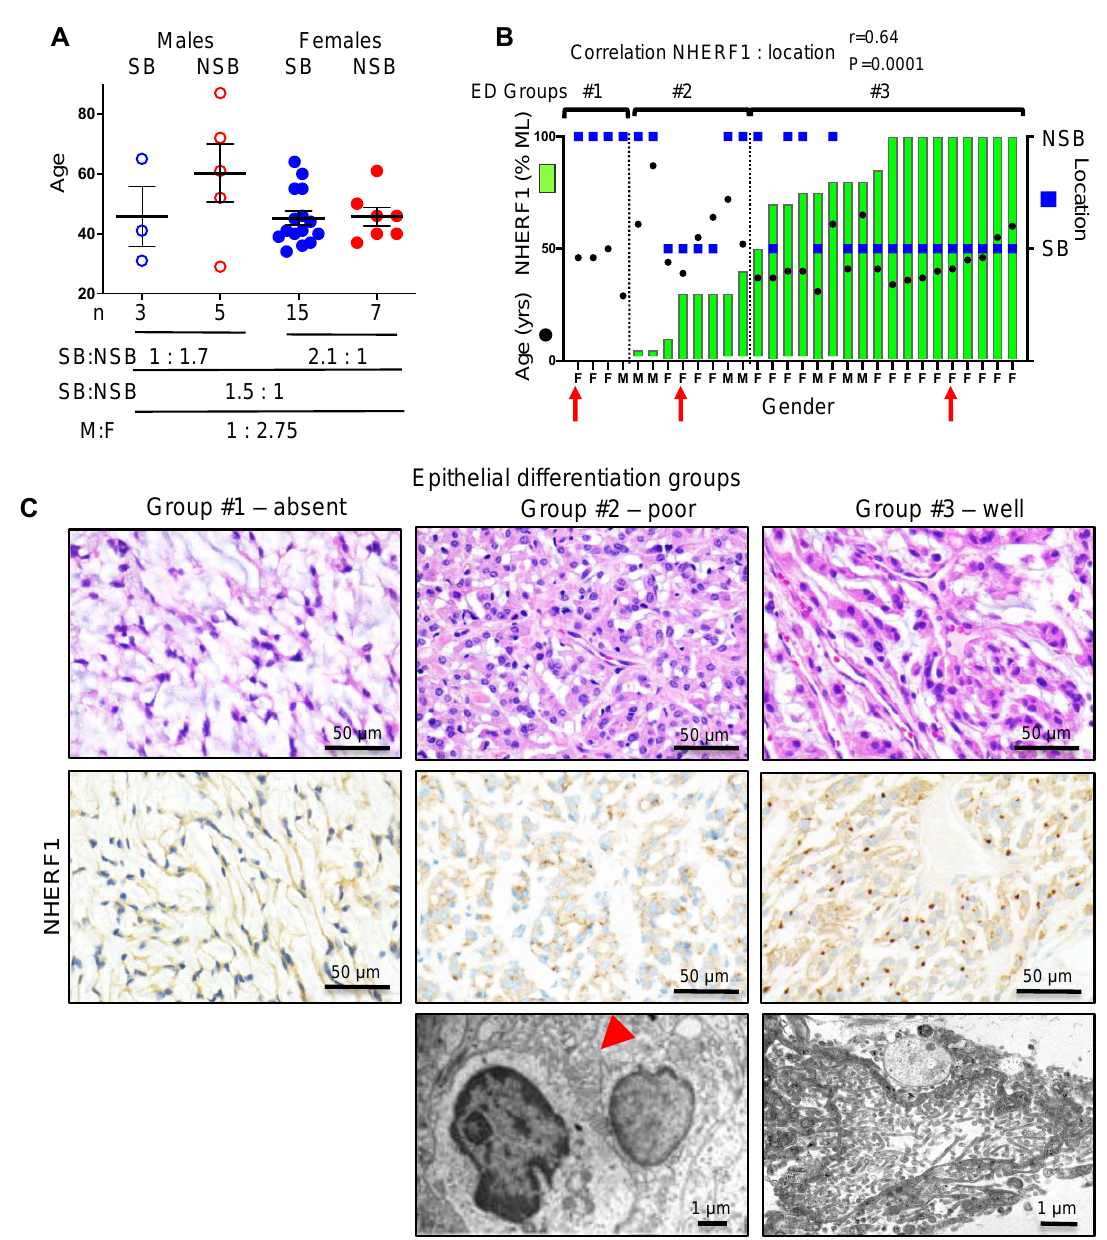
Figure 1. NHERF1 microlumen (ML) extent reveals three epithelial differentiation (ED) groups in chordoid meningioma. ( A ) Age, sex, and location for a cohort of 30 patients with chordoid meningioma. The individual distribution and mean ± SEM are indicated. M, male; F, female; SB, skull base; NSB, non-skull base. ( B ) Graphic representation of NHERF1 ML distribution, age, and location reveals three ED groups and significant correlation of NHERF1 ML extent with SB location: r, Spearman coefficient. ( C ) H&E, NHERF1 IHC, and electron microscopy images from the 3 representative cases in each ED group, indicated with red arrow in ( B ). Red arrowhead indicates a pocket with microvilli. Table 1. Chordoid meningioma: demographic, clinical, histologic and genomic characteristics.